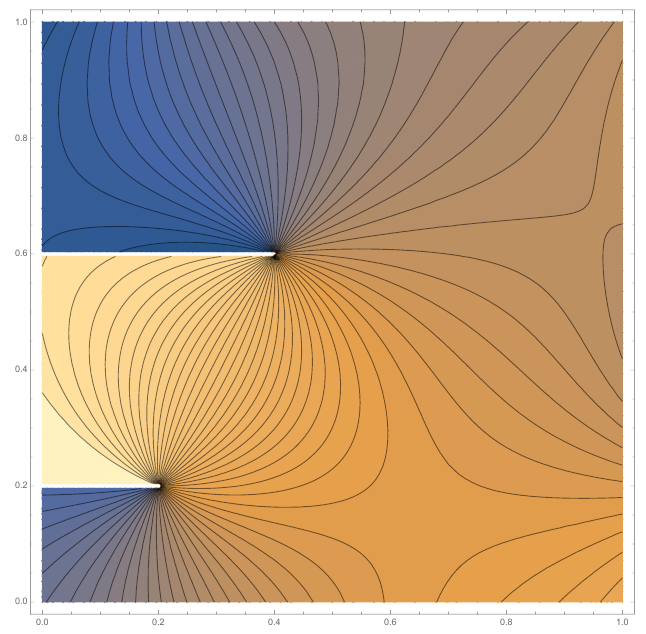
Figure 3 . Curves H = const with τ = i , with τ = i , Z 1 = 0 . 2(1 + i ) , Z 2 = 0 . 4 + 0 . 6 i P 1 = 0 . 643 + 0 . 129 i and P 2 = 0 . 956 + 0 . 662 i